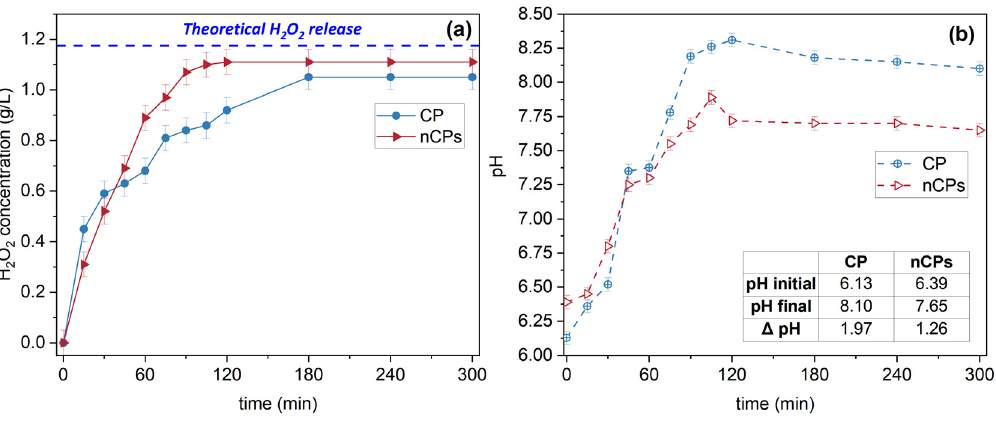
Figure 10. ( a ) Release of H 2 O 2 by CP and nCPs under stirring condition (150 rpm, RT), [CaO 2 ] = [nCPs] = 2.5 g/L. ( b ) The change of pH with time of CP and nCPs.